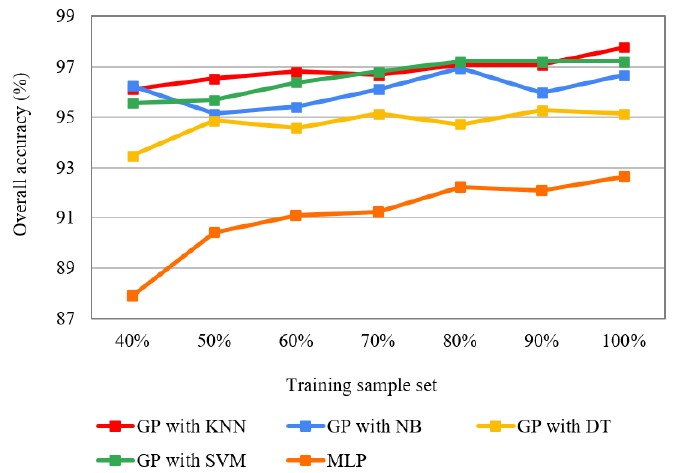
Figure 14. The overall accuracies of the GP wrapped four classifiers (i.e., KNN, NB, DT and SVM), and MLP for various training subsets.